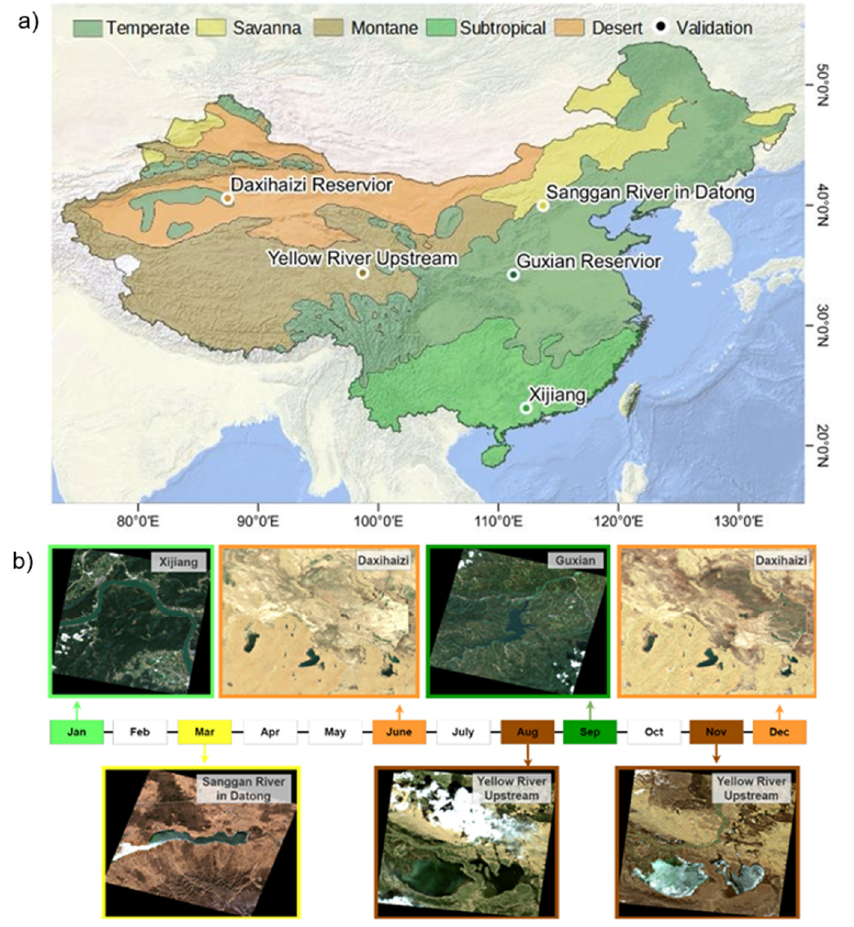
Figure 2. The location of the validation sites displayed along with the RESOLVE eco-region map (a). The seasonal distribution of the validation months by site and shown along with Sentinel-2 quick looks (b).